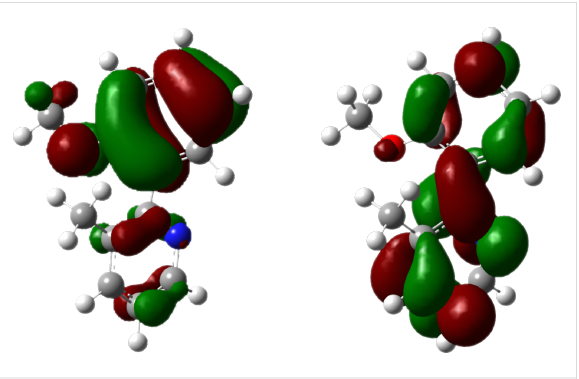
Figure 5: HOMO (left) and LUMO (right) of the 3-methylpyridine 7 calculated by using B3LYP/6-31G*.